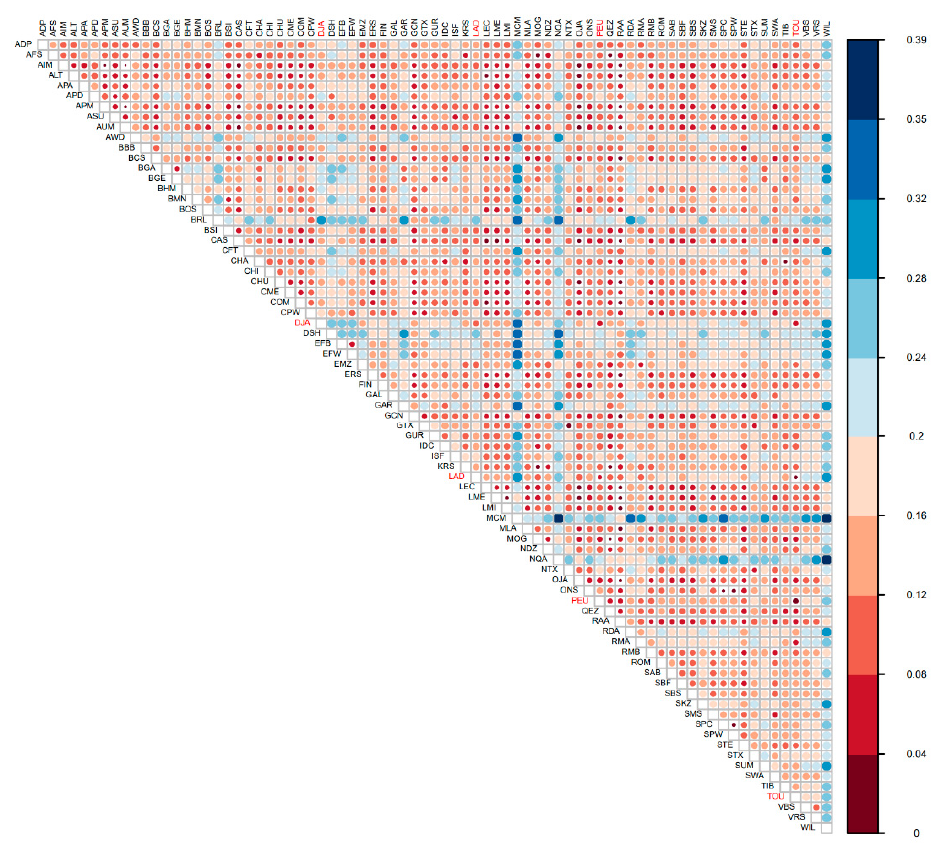
Figure 4. Pairwise Fst among 77 breeds estimated from different SNP datasets. Acronyms of Sene- galese sheep breeds are coloured in red. Table 4. Within-breed genetic diversity indices in 77 breeds estimated from different SNP da- tasets.